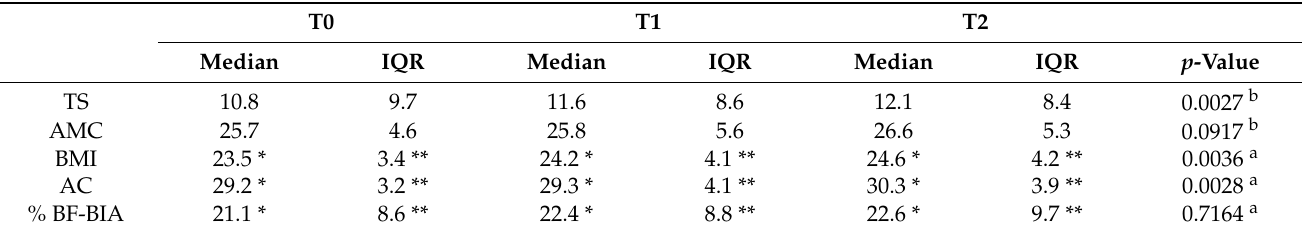
Table 4. Comparison of the nutritional parameters of PLHIV between the periods evaluated.